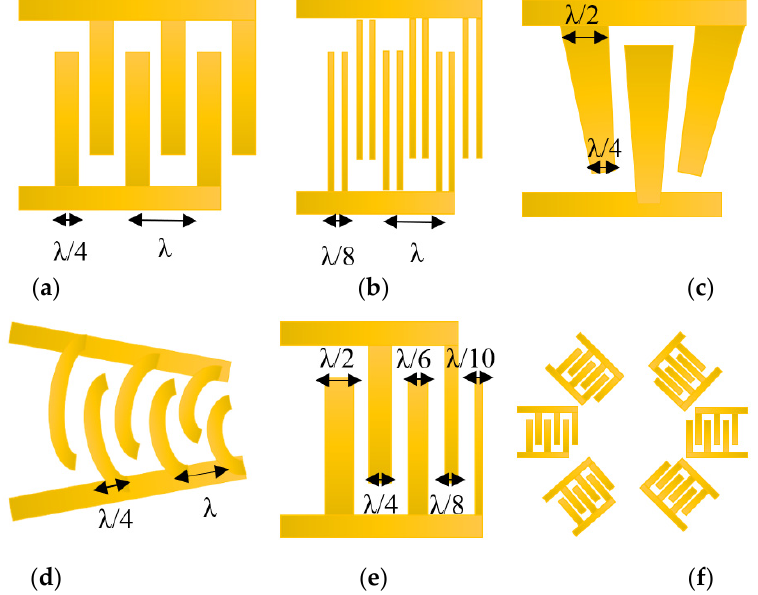
Figure 12. IDT used for cell analysis application ( a ) Simple IDT, ( b ) Single-Phase Unidirectional Transducer (SPUDT) IDT, ( c ) Slanted IDT, ( d ) Focused IDT, ( e ) chirped IDT, and ( f ) Multiple IDT.